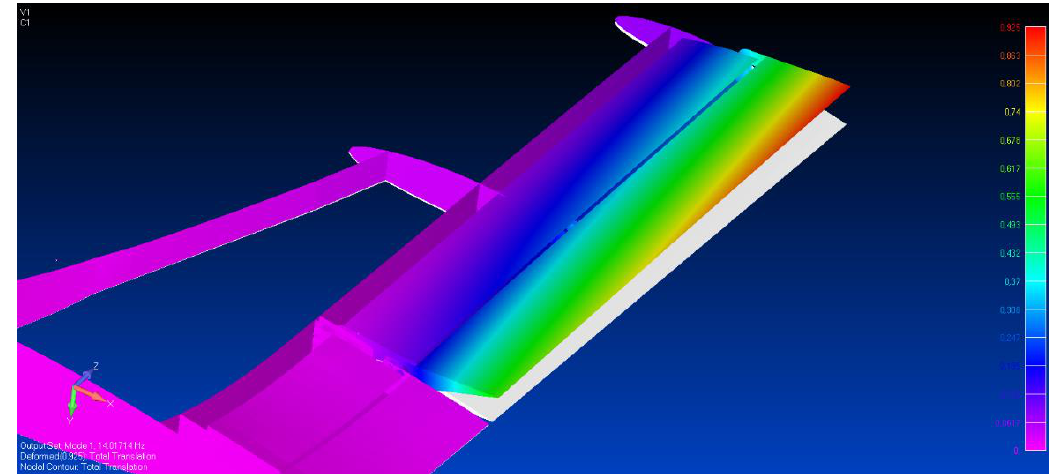
Figure 13. Morphing mode of the upper-morphing tab in operative condition (frequency = 14 Hz).